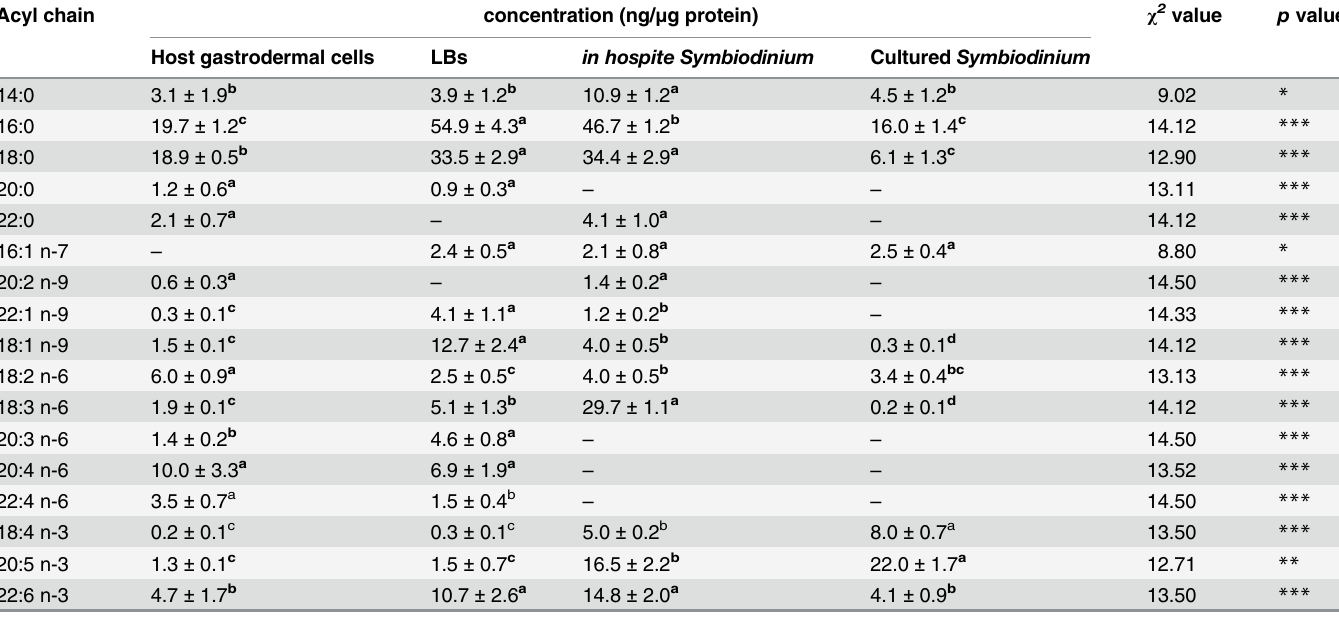
Table 1. Concentrations of fatty acid acyl chains from host coral gastrodermal cells, LBs, in hospite Symbiodinium , and cultured Symbiodinium .